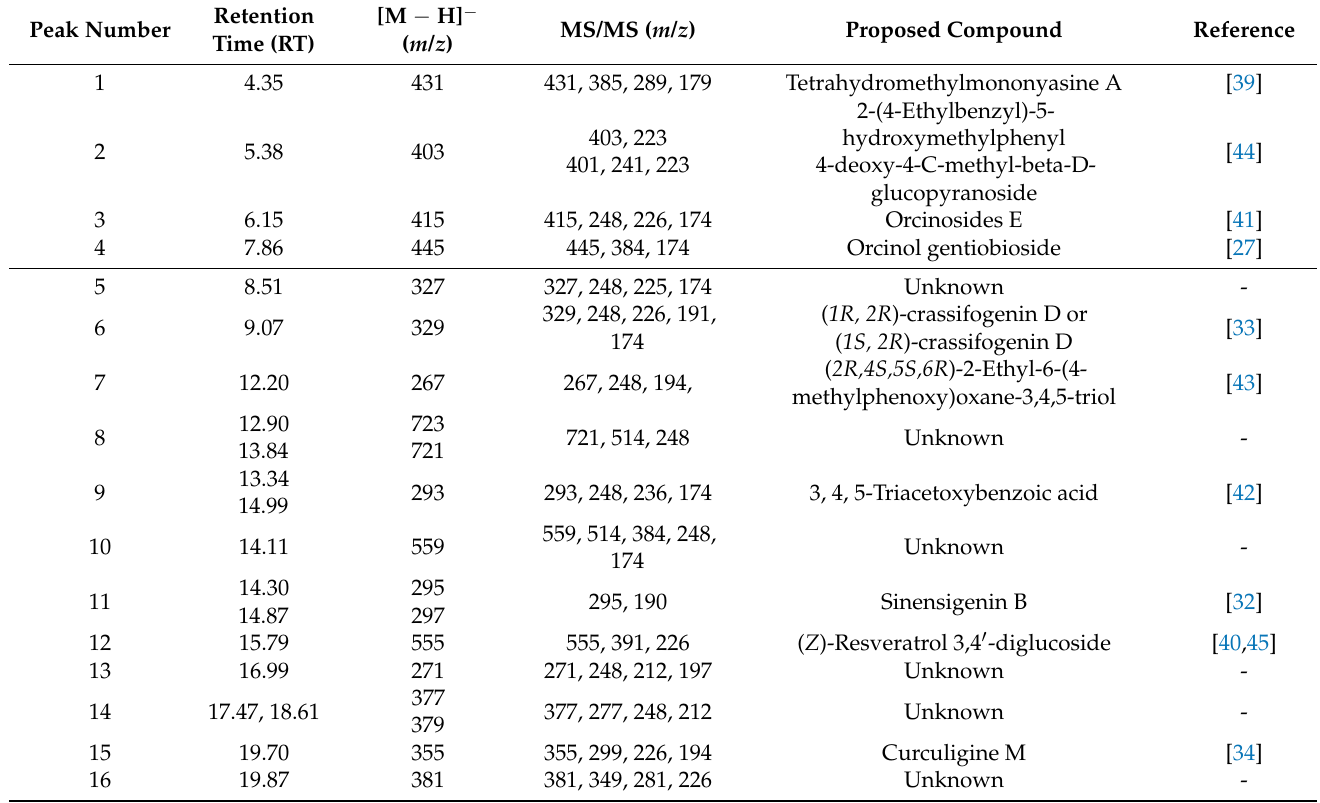
Table 2. Annotated compounds based on LC-MS/MS and MN identified in the leaf extract of Curculigo latifolia . The table shows peak number, proposed compound, retention time in minutes (RT), parent ion [M − H] − , mass-per-charge ratio, MS/MS mass per charge ratio of fragment ions, and references.